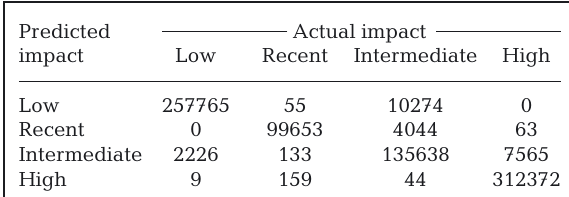
Table 1. Confusion matrix of aggregated counts from 100 rounds of 10-fold, 100 repetition cross validation created during a hyperparameter search (N = 83) with randomly sampled seed states. Column and row values correspond to known and predicted cases of seafloor disturbance, respec- tively, with 4 levels of seafloor disturbance ranging from low to high. Numbers represent the result of 100 seed iterations of independent train/test